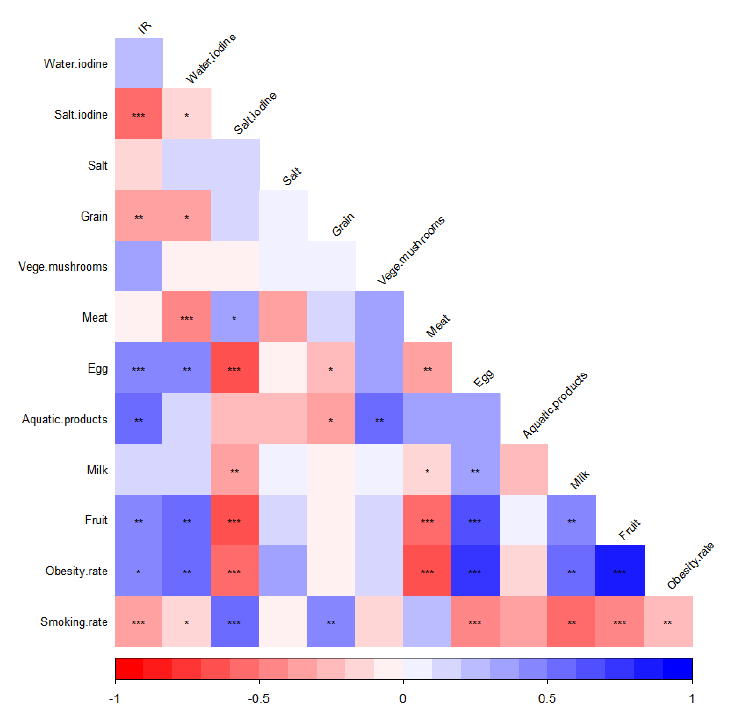
Figure 6. Heatmap of associations between dietary behavior factors and TC incidence. Note: p < 0.05 *, p < 0.01 **, p < 0.001 ***.